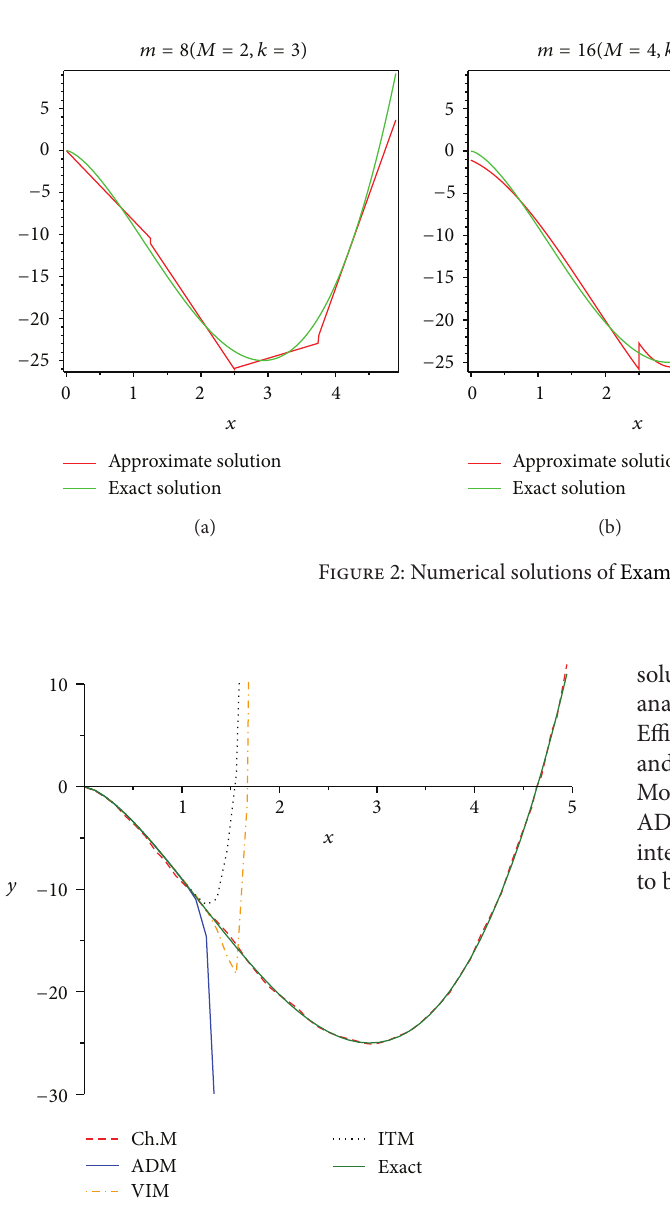
Figure 3: Numerical solutions of Example 1 for 𝛼 = 0.75 .